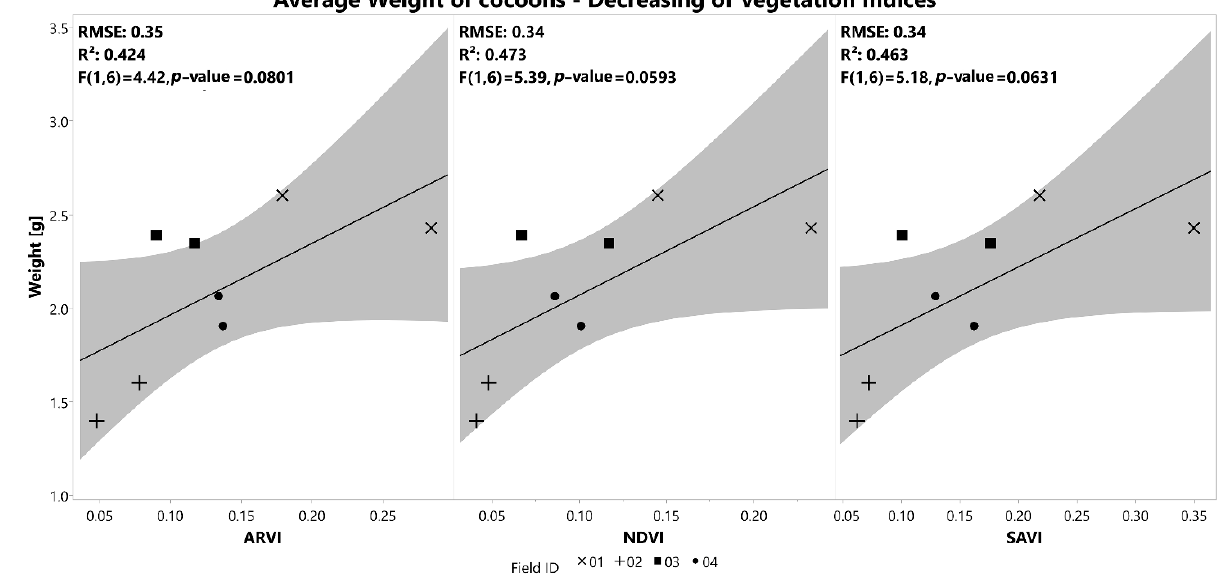
Figure 6. Average weight of cocoons [g] in relation to decreasing vegetation indices during the fifth